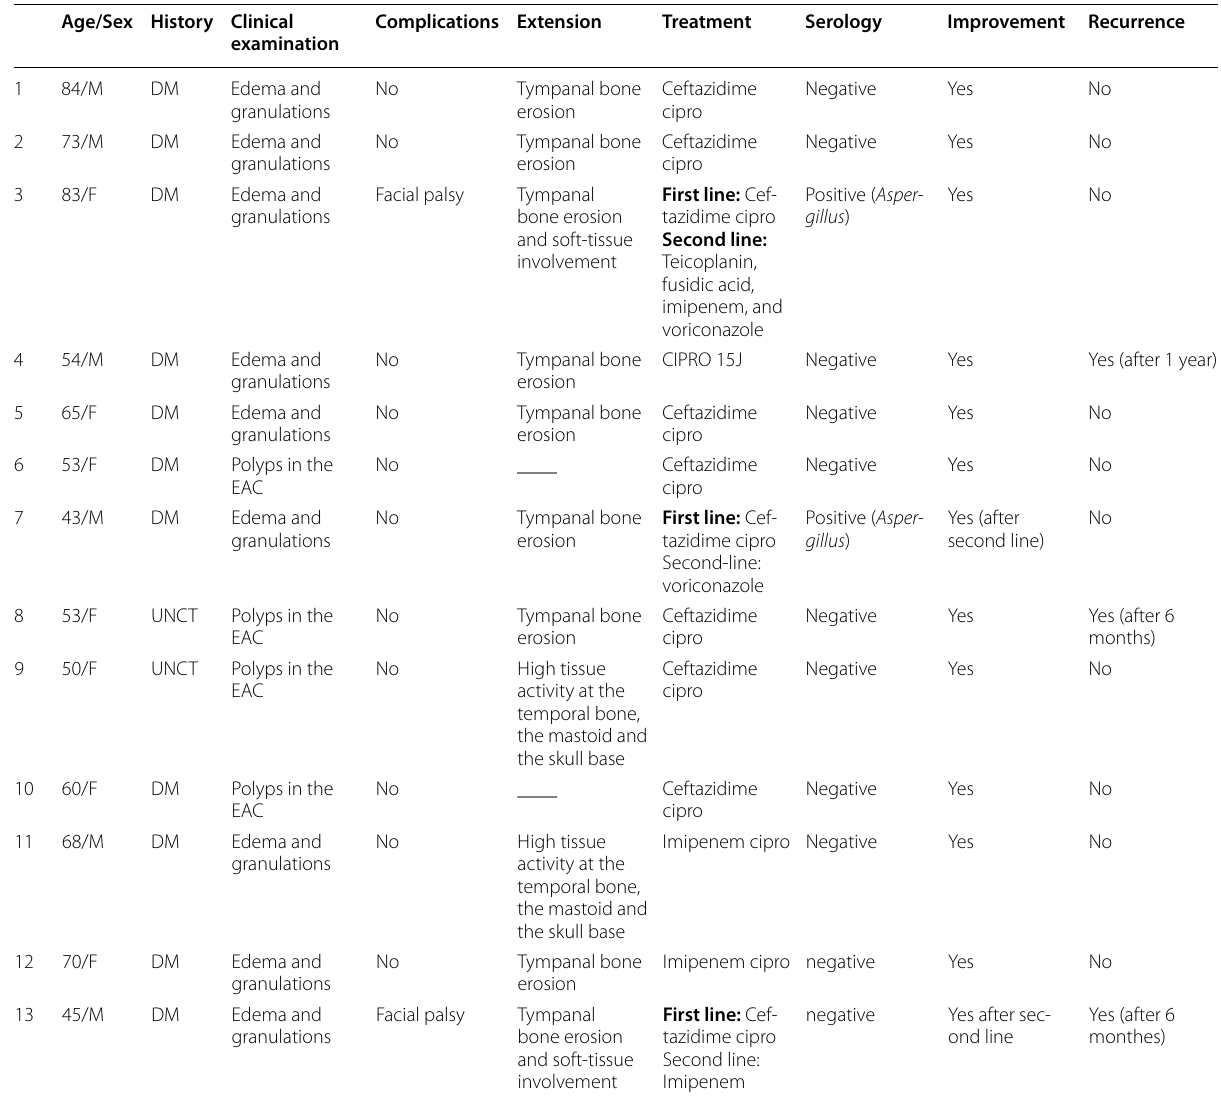
Table 2 Clinical and therapeutic features of